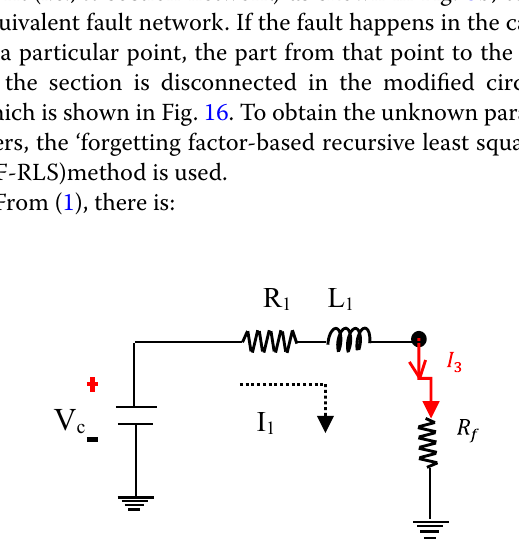
Fig. 16 Equivalent circuit for Pole–Ground